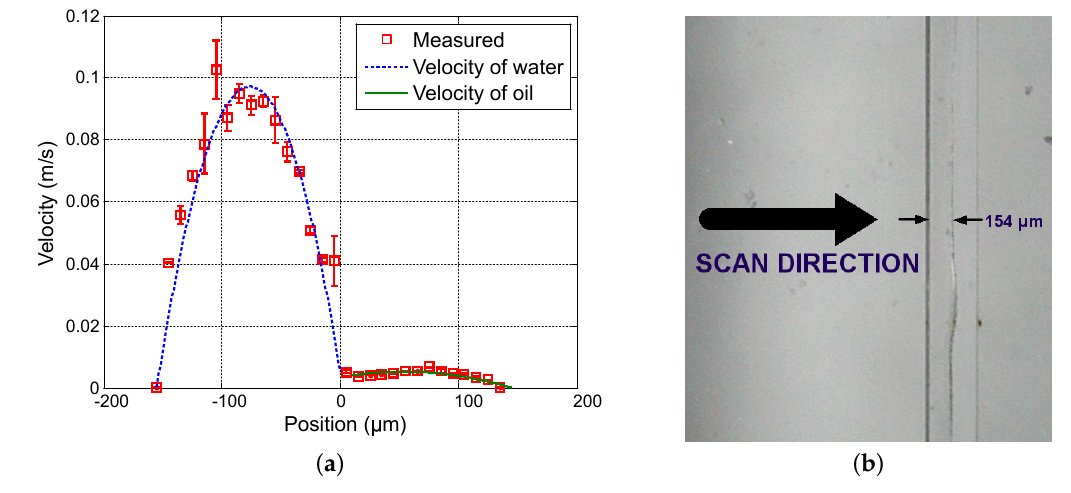
Figure 6. Experimental results for Q water = 50 µL · min − 1 and Q oil = 3 µL · min − 1 . ( a ) measured profile (squares) and theoretical profile for water (dashed line) and for oil (solid line); and ( b ) reference image of the main channel with indication of the interface location.